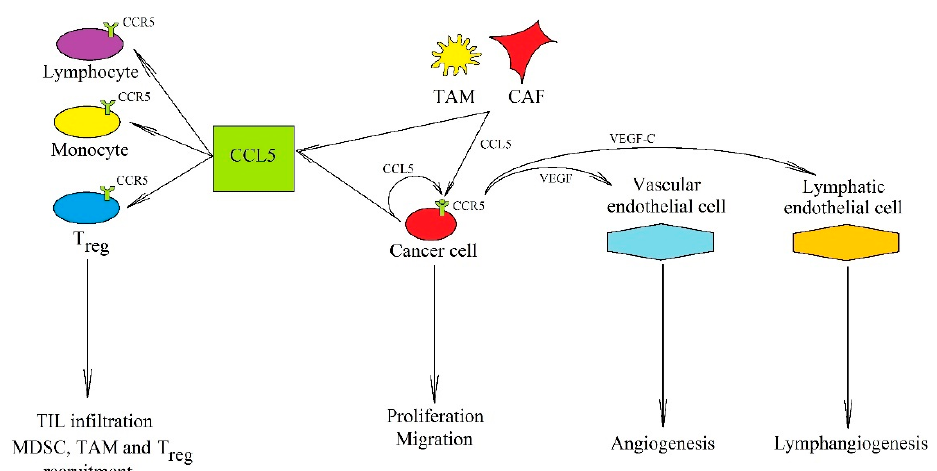
Figure 2. The significance of the CCL5 → CCR5 axis in cancer processes. In a tumor, CCL5 is secreted by tumor cells and also by TAM and CAF. Its anti-cancer properties consist of inducing cytotoxic TIL infiltration that increases the anticancer response of the immune system. Its pro-cancer effect is associated with (i) recruitment of cells participating in cancer immune evasion: MDSC, TAM, and T reg , (ii) induction of proliferation, migration, and invasion of cancer cells, and (iii) causing an increased production of VEGF, which leads to angiogenesis and lymphangiogenesis.